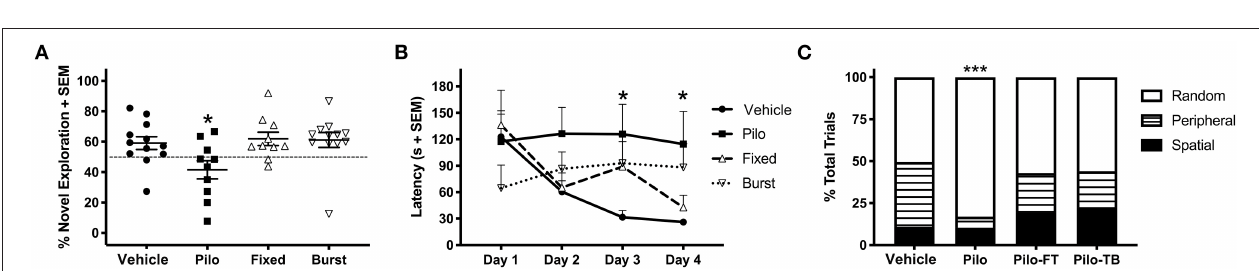
FIGURE 4 | Longitudinal changes in vHPC power. (A) Prior to the administration of pilocarpine (baseline), oscillatory power was similar between the groups. (B) However, theta, delta, and beta power significantly decreased on PPD4 (normalized to baseline) in animals treated with pilocarpine as compared with Vehicle. (C) Animals counterbalanced into stimulation groups demonstrate no difference in 6–10Hz power prior to the initiation of stimulation (PPD4). (D) When normalized to PPD4, PPD31 power was not significantly different between treatment groups. ** p < 0.01, *** p < 0.001.